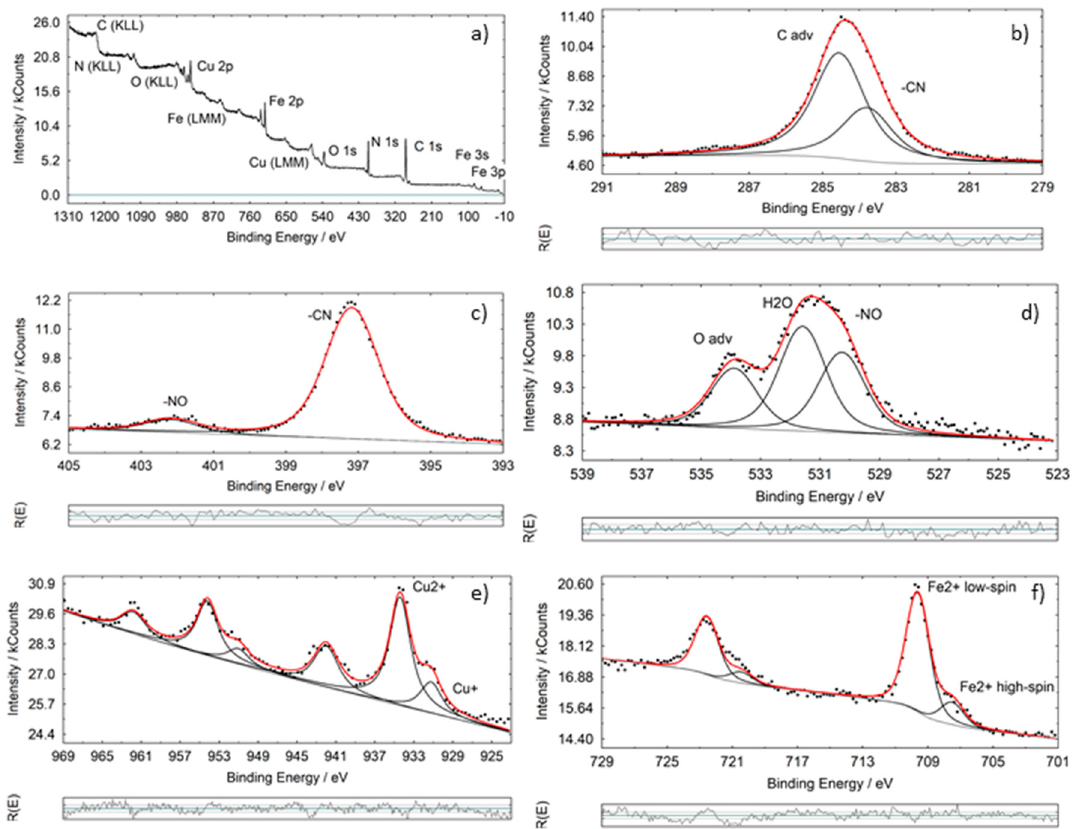
Figure 1. XPS fitted data of copper nitroprusside I. The detailed spectra reported are ( a ) survey ( b ) C 1s ( c ) N 1s ( d ) O 1s ( e ) Cu 2p and ( f ) Fe 2p (in red: sum of fitting result; solid lines: background or peak contribution). Table 1. Values of binding energies (in eV) for CuNPs samples. Binding Energies (eV)